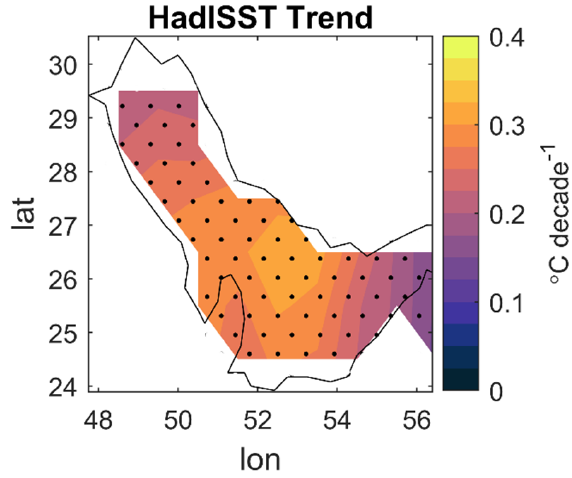
Figure 5. The spatial HadISST trend in °C decade − 1 during the summer season. The dot area indicates the significant area at 95%.